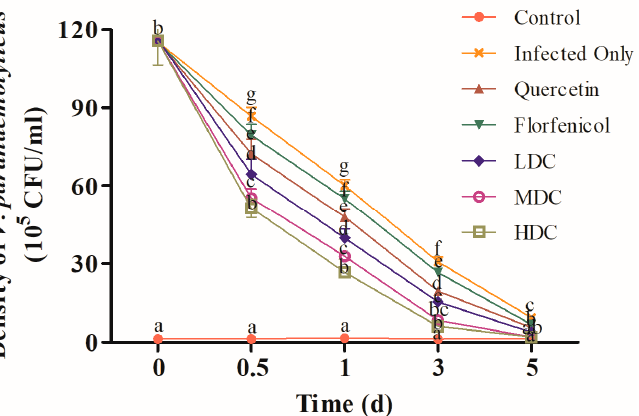
Figure 2. The VP AHPND density in the hepatopancreas of L. vannamei at different times after drug treatment. One-way ANOVA and Duncan’s multiple range test were used to analyze the significant differences among different groups, and different letters represent significant differences between groups ( p <